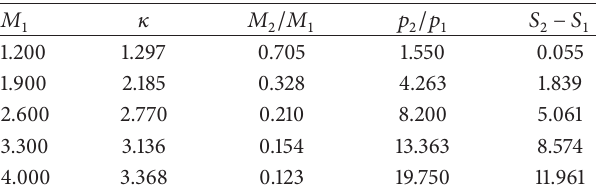
Table 1: Change of physical parameters for inviscid shock waves ( 𝜇 = 0 , i.e., higher Re).